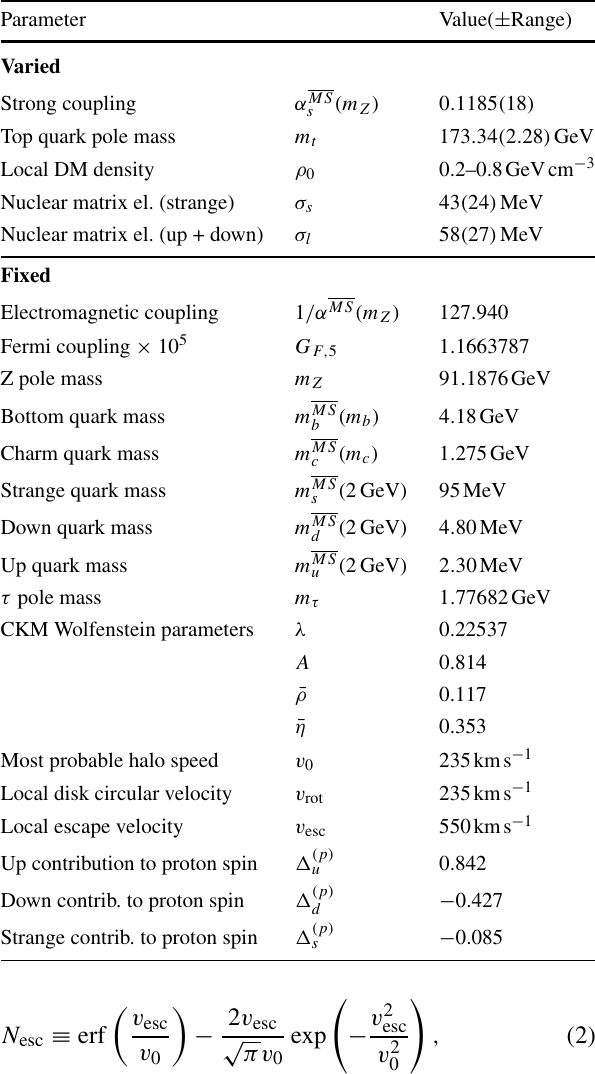
Table2 StandardModel,darkmatterhaloandnuclearnuisanceparam- eters and ranges. We vary each of the parameters in the first section of the table simultaneously with CMSSM, NUHM1 or NUHM2 param- eters in all of our fits, employing flat priors on each. The parameters listed in the second section of the table are constant in all